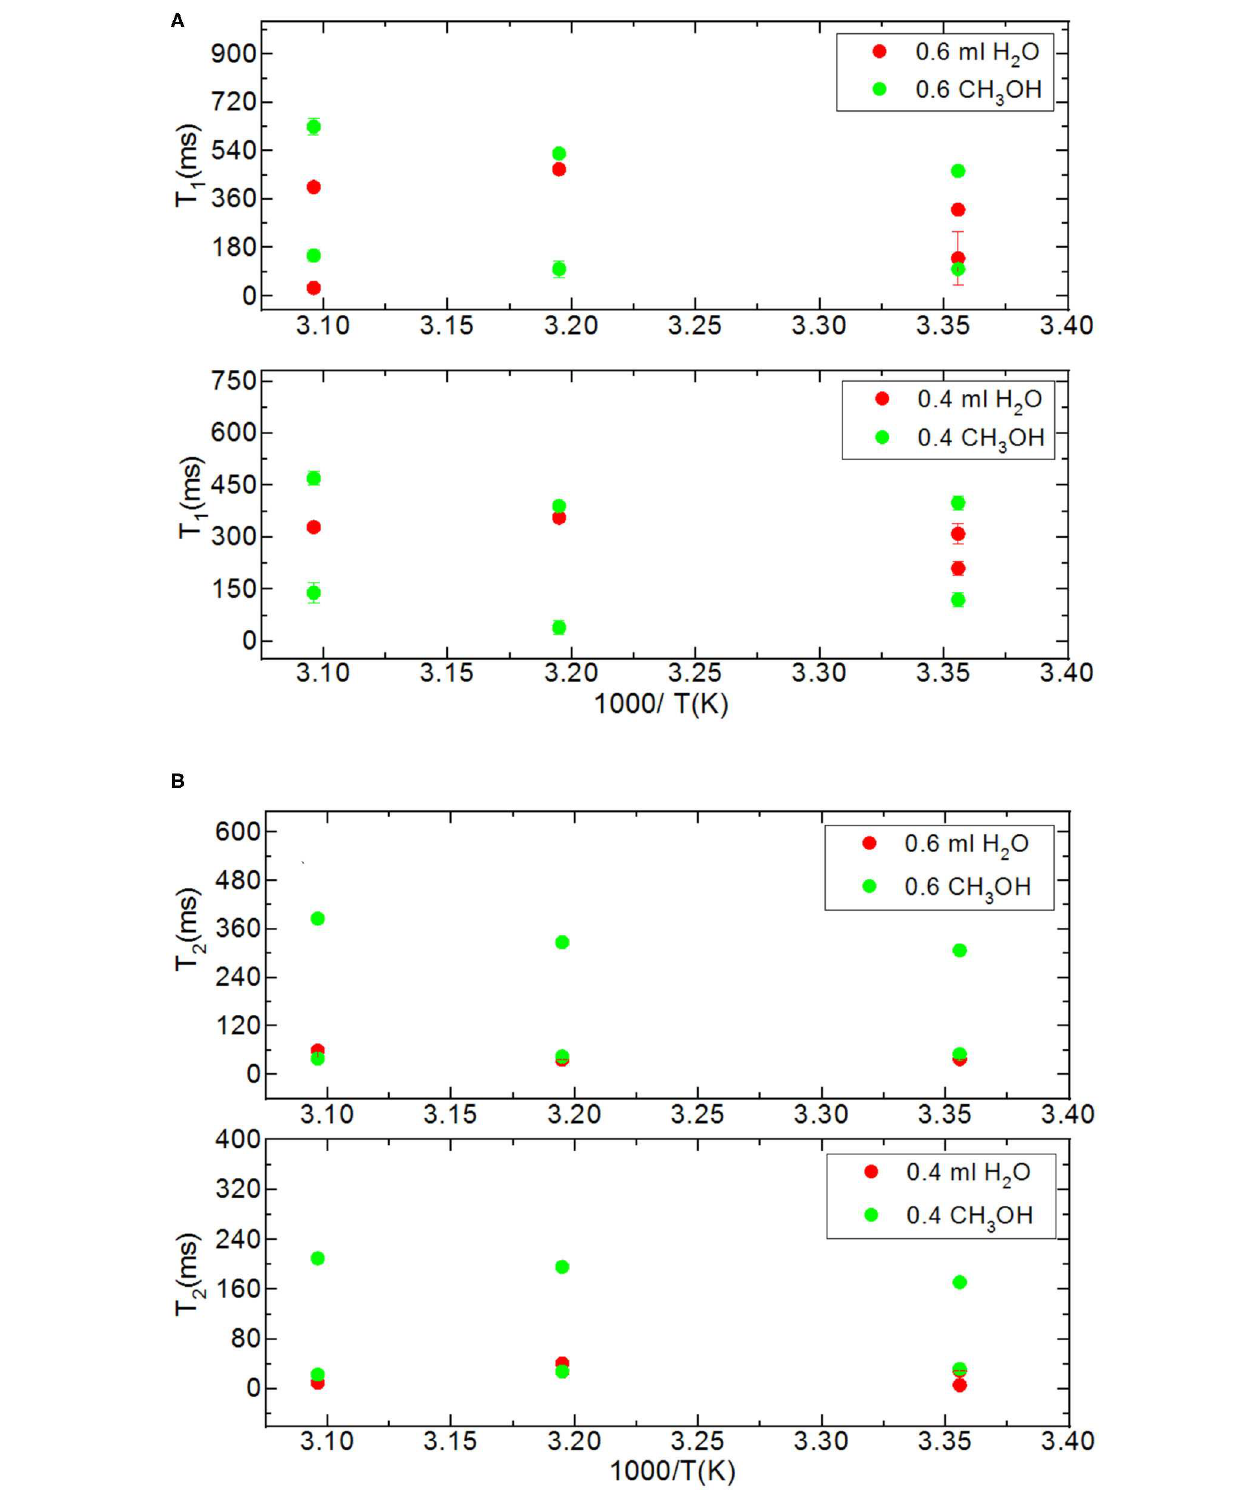
FIGURE 4 | Comparison of relaxation values of H 2 O and CH 3 OH confined into silica-4.0nm with the amount of 150mg and S/V = 574 where the variables are temperature values (298, 313, and 323K), and fluid-to-solid ratios (0.60 ml/150mg, 0.40 ml/150mg); T 1 (A) and T 2 (B) .